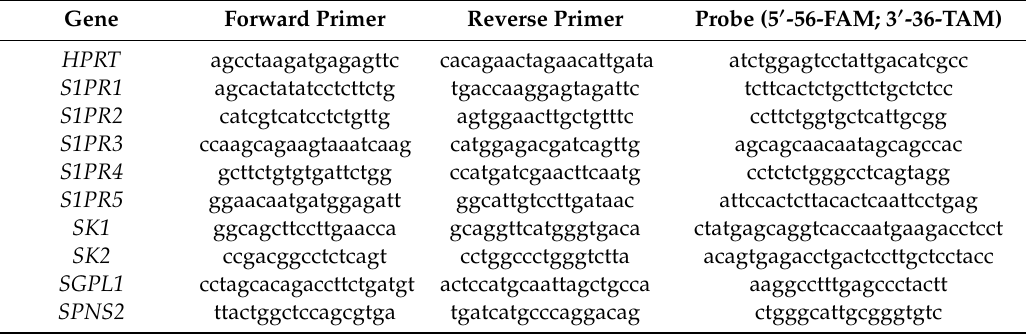
Table 1. Sequences of primers and probes used for quantitative polymerase chain reaction (qPCR)